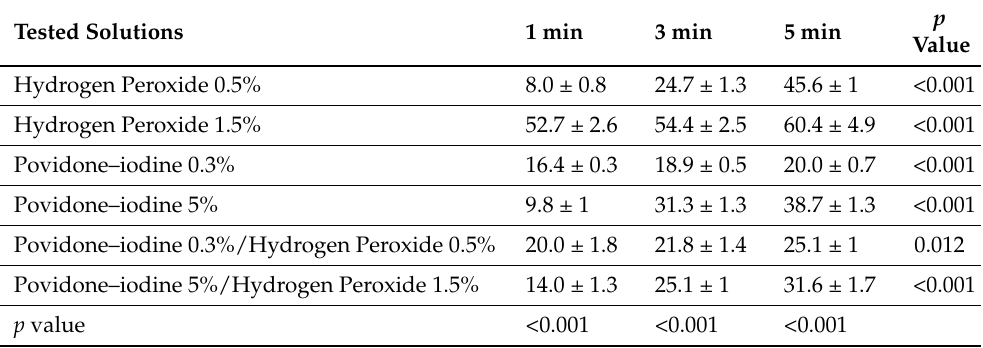
Table 4. Toxicity data in fibroblast-like